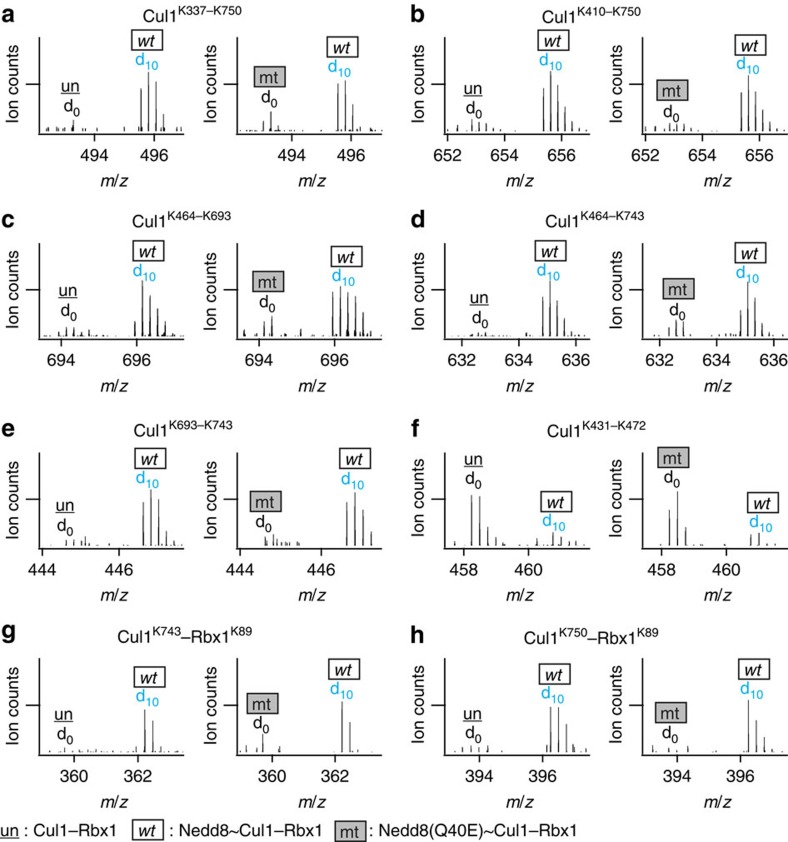
Deciphering the structural dynamics of Cul1–Rbx1 complexes using QXL-MS.Eight selected K–K linkages are presented to describe conformational changes in the three types of Cul1–Rbx1 complexes. Two sets of pairwise comparison results (that is, un (d0) versus wt (d10) and mt (d0) versus wt (d10)) are displayed for each selected cross-link, in which both the un and mt forms were cross-linked by d0-DMDSSO and the wt form was cross-linked by d10-DMDSSO. MS1 spectra of (a) Cul1K337–K750, (b) Cul1K410–K750, (c) Cul1K464–K693, (d) Cul1K464–K743, (e) Cul1K693–K743, (f) Cul1K431–K472, (g) Cul1K743–Rbx1K89 and (h) Cul1K750–Rbx1K89. The sequences of these cross-links are summarized in Supplementary Table 1. The relative spectral abundance of cross-links (d0:d10) measured during MS analysis describes the cross-linkability of lysine residues in 3D structure.